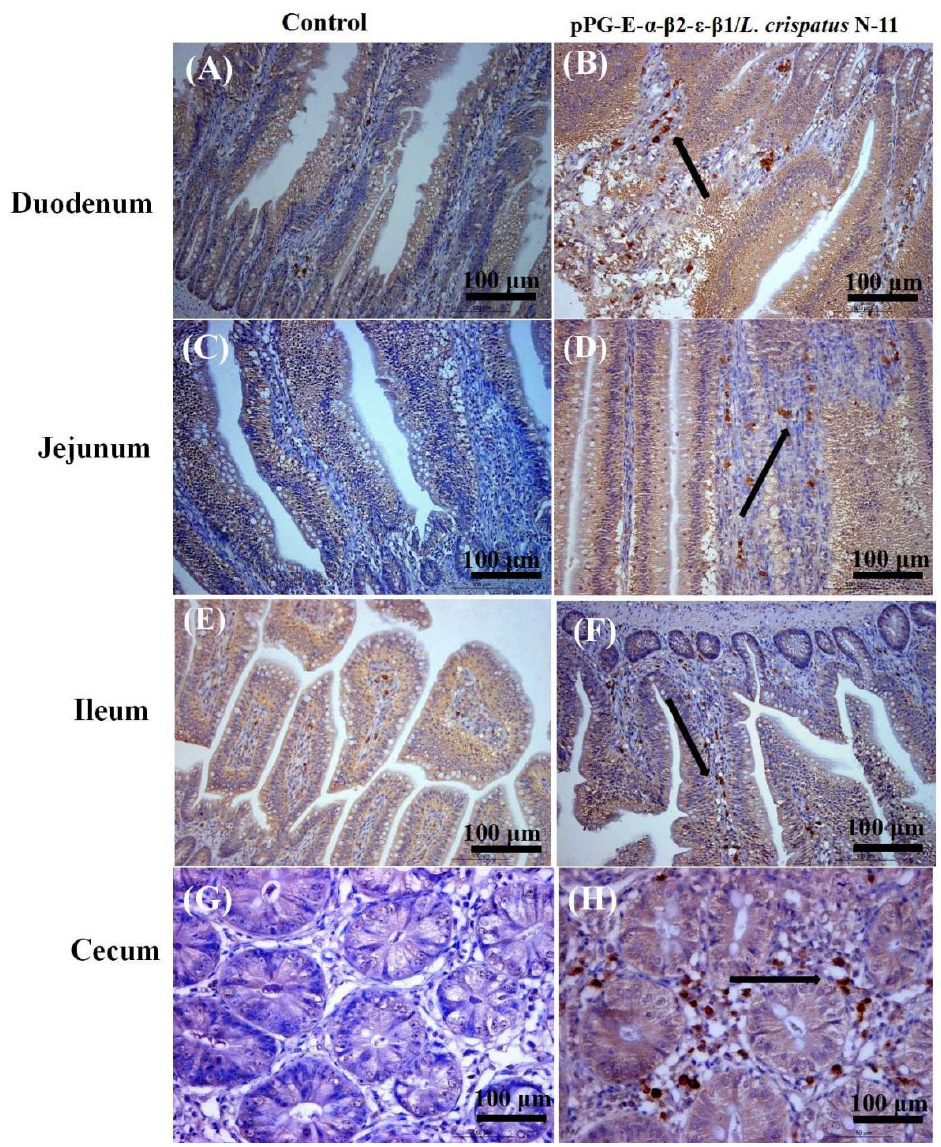
Figure 6. Immunohistochemical assay of chicken immunized with pPG-E- α - β 1- ε - β 2/ L. crispatus N-11. The control group ( A , C , E , G ) showed significantly lower IgA positive cells as compared to the pPG-E- α - β 1- ε - β 2/ L. crispatus N-11 group ( B , D , F , H ), indicating that pPG-E- α - β 1- ε - β 2/ L. crispatus N-11 could effectively enhance mucosal immunity. The black arrows indicate antigen immunoreactivity and the IgA positive cells in the immunized group.